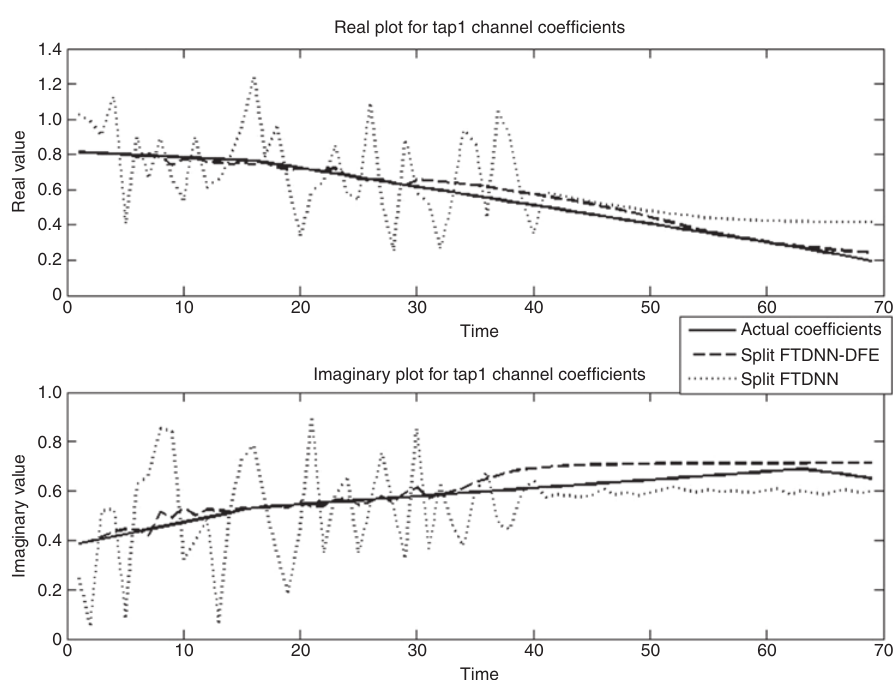
Figure 10: Channel Gain Plot for Case